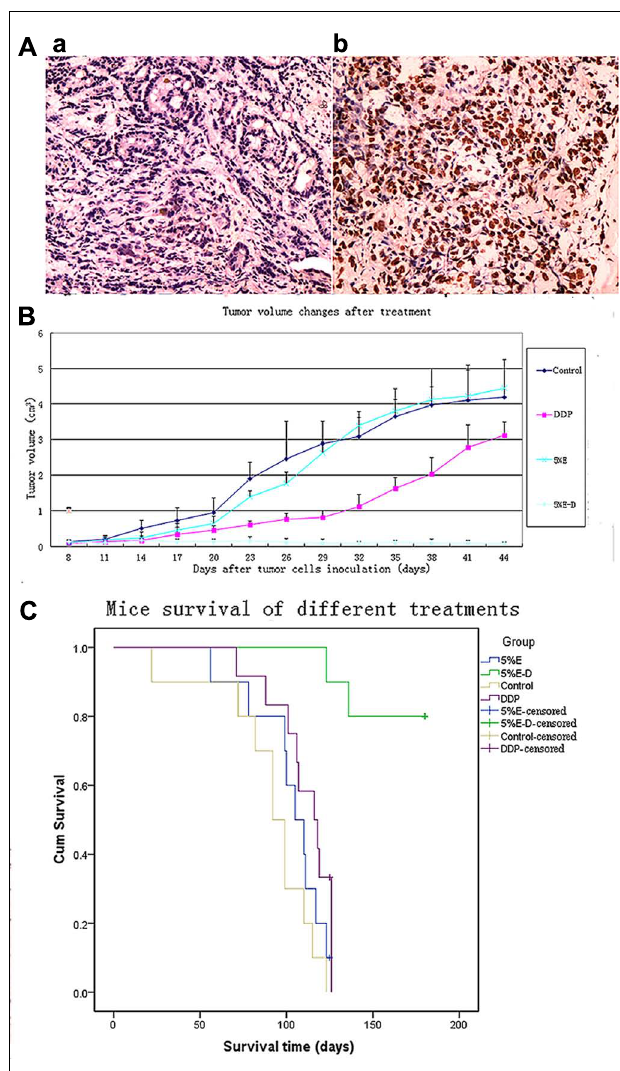
FIGURE 3 | (A) Apoptosis analysis of 5% ethanol–DDP-treated tumor tissues withTUNEL staining. (a) Control tumor tissue. (b) 5% ethanol–DDP treated tumor tissue. Compared with control, 5% ethanol–DDP significantly increased tumor cell apoptosis rate (60.11% ± 7.52% vs. 5.32% ± 1.76%, p < 0.05). (B) DDP-resistant tumor size changes by various treatments. 5% ethanol–DDP significantly inhibited tumor growth compared with control or DDP alone or 5% ethanol after 4 weeks’ treatment. E–D stands for ethanol–cisplatin. (C) Survival of A549/DDP tumor-bearing mice in different groups. 5% ethanol–DDP treatment significantly improved estimated mean survival time compared with control or DDP alone or 5% ethanol. E–D stands for